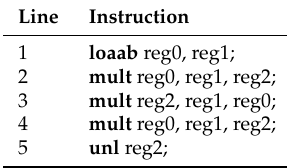
Table 6. Listing of code for n -th power of n computations ( n =